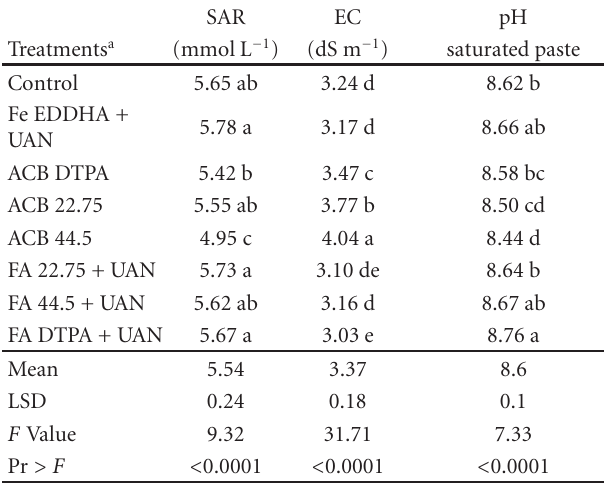
a Refer to Experimental Design and StatisticalAnalysis section for treatment